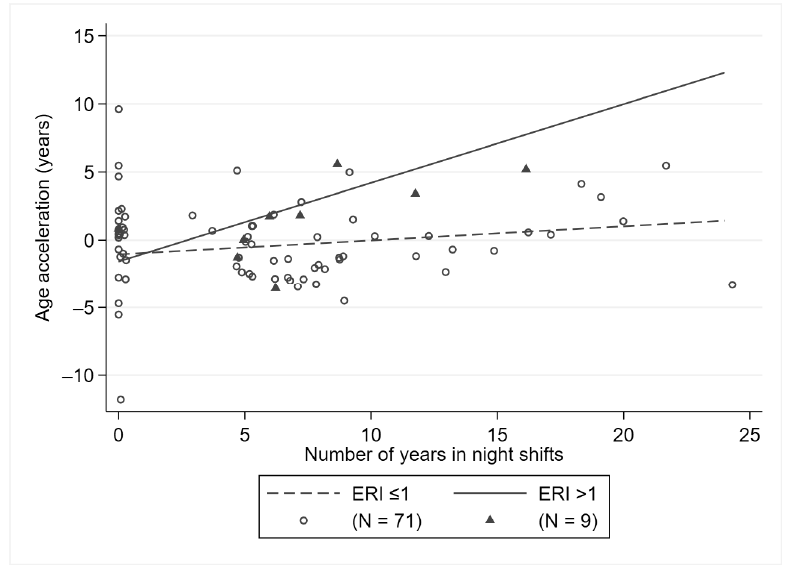
Figure 2. Association between the number of years in night shifts and age acceleration, stratified by